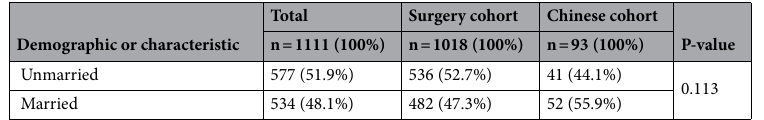
Table 2. Patient demographics and clinicopathologic characteristics in surgery cohort and Chinese validation cohort. *1: American Indian/AK Native, Asian/Pacific Islander; 2: central portion of breast or nipple; 3: Breast,NOS.